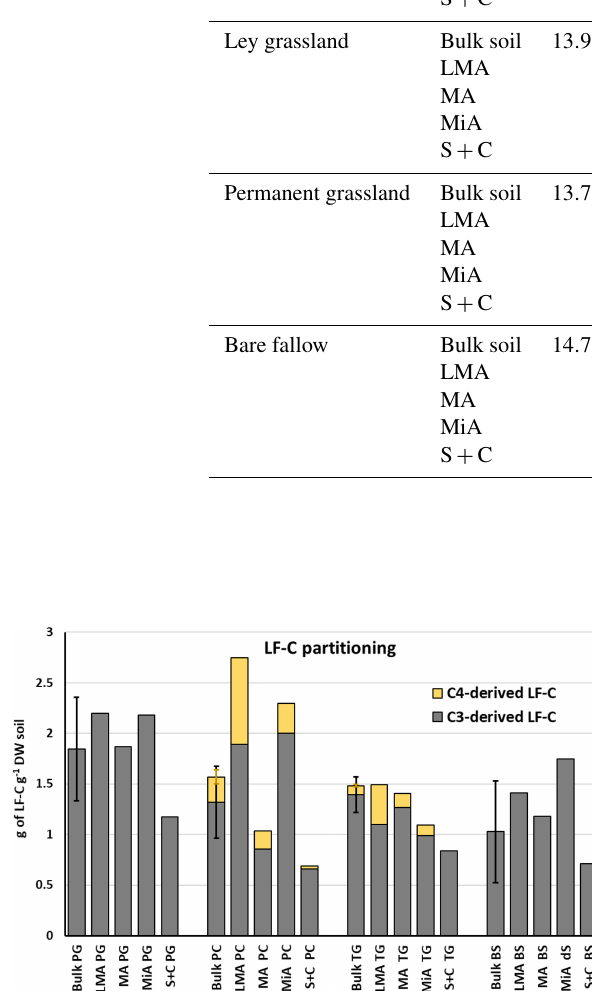
Figure 4. C3 and C4 light fraction C contributions to total light fraction C for different treatments and soil fractions. Note: PG – permanent grassland; LG – ley grassland; PC – permanent crop- land; BF – bare fallow soil; LMA – larger macroaggregate; MA – macroaggregate; MiA – microaggregate; and S + C – silt and clay. No significant differences between treatments ( P < 0 . 05) were found for bulk soil samples. Error bars show the calculated stan- dard deviations for replicate